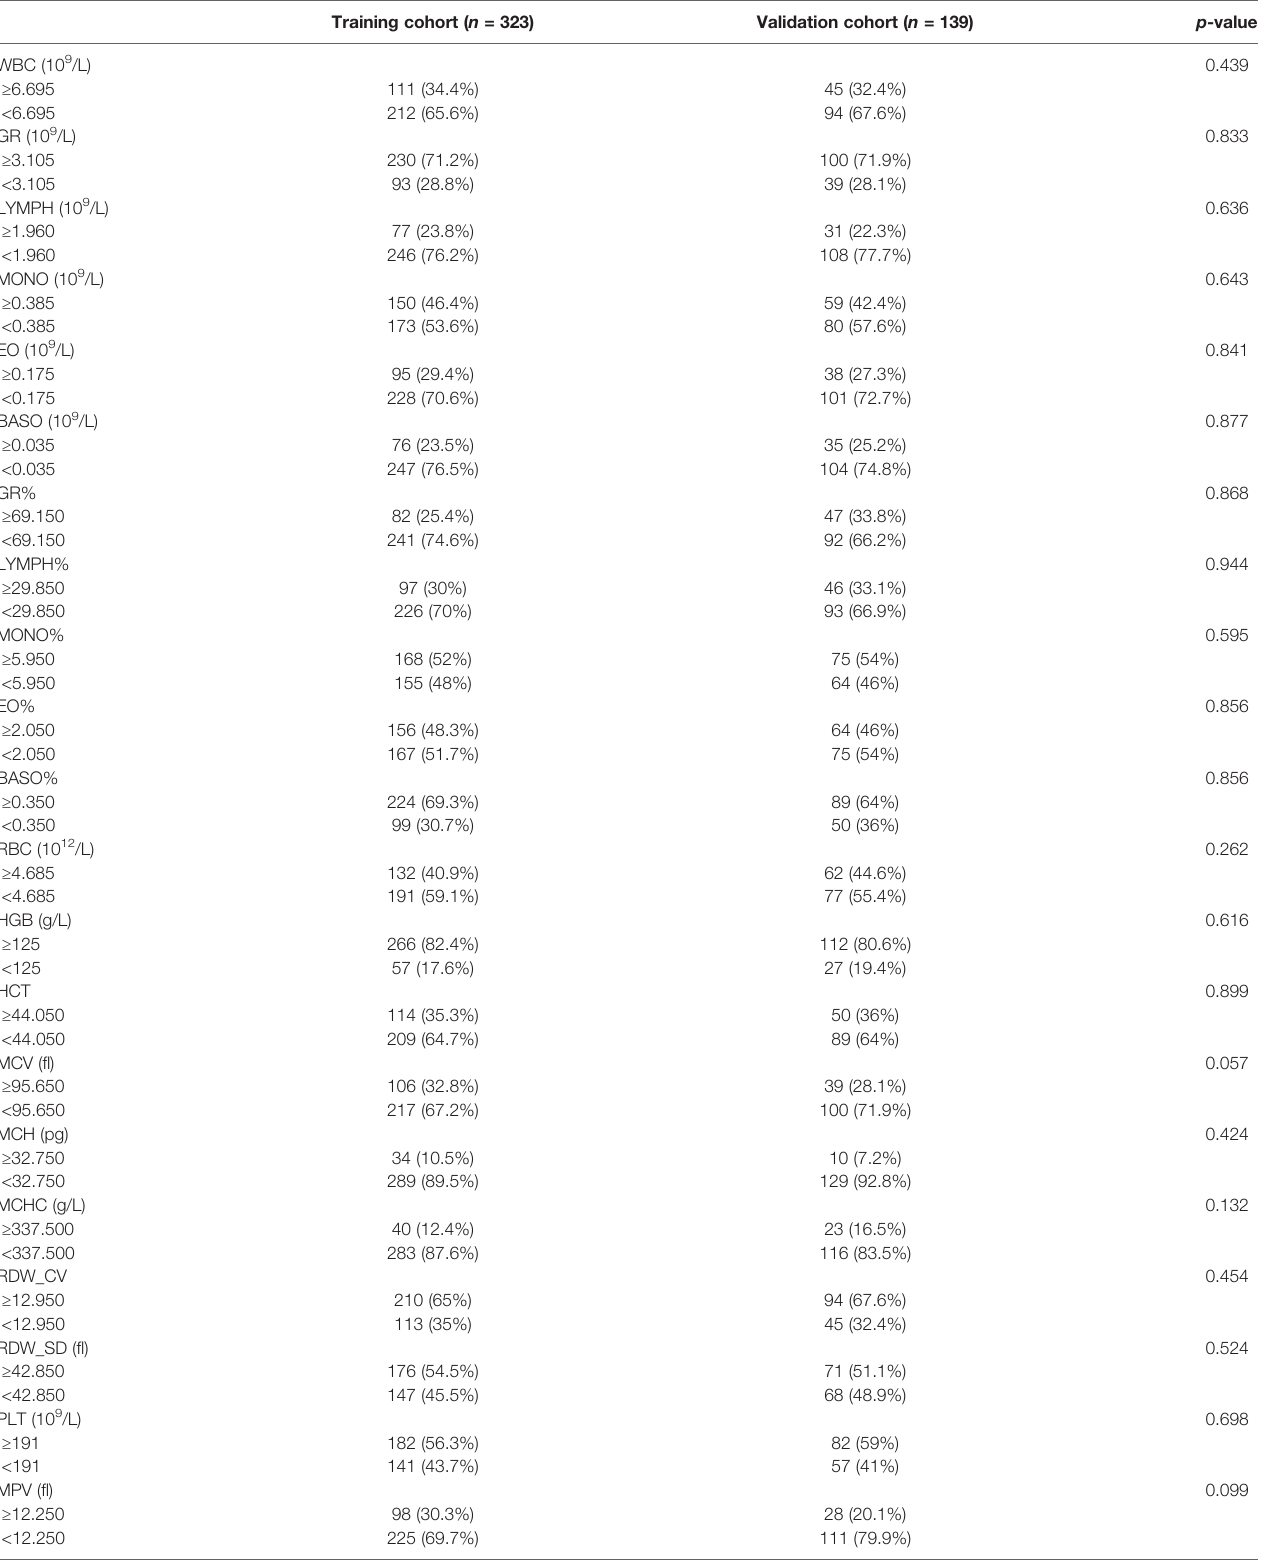
TABLE 2 | Blood parameters in the training and validation